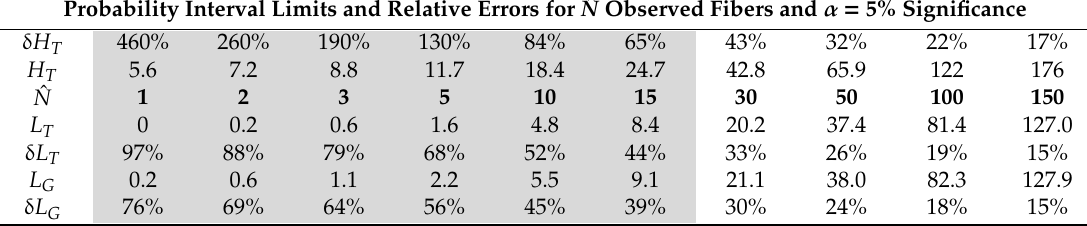
Table A2. Upper and lower limits of twin hypothesis testing for Frequentist ( L T and H T ) and Bayesian theorem ( L G ) probability intervals as calculated from Equations (A5), (A6) and (A12) for ˆ N observed fibers and a significance level of α = 5%. Gray areas indicate fiber counts with relatively large